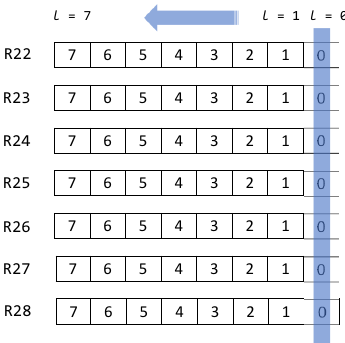
Figure 1. Multiplier accessing pattern in common Block-Comb